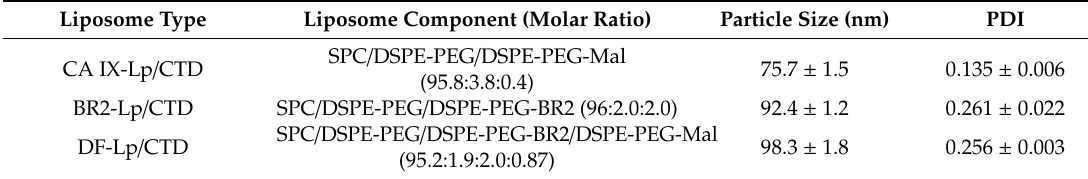
Table 1. Characterization of di ff erent liposome formulations (mean ± SD).